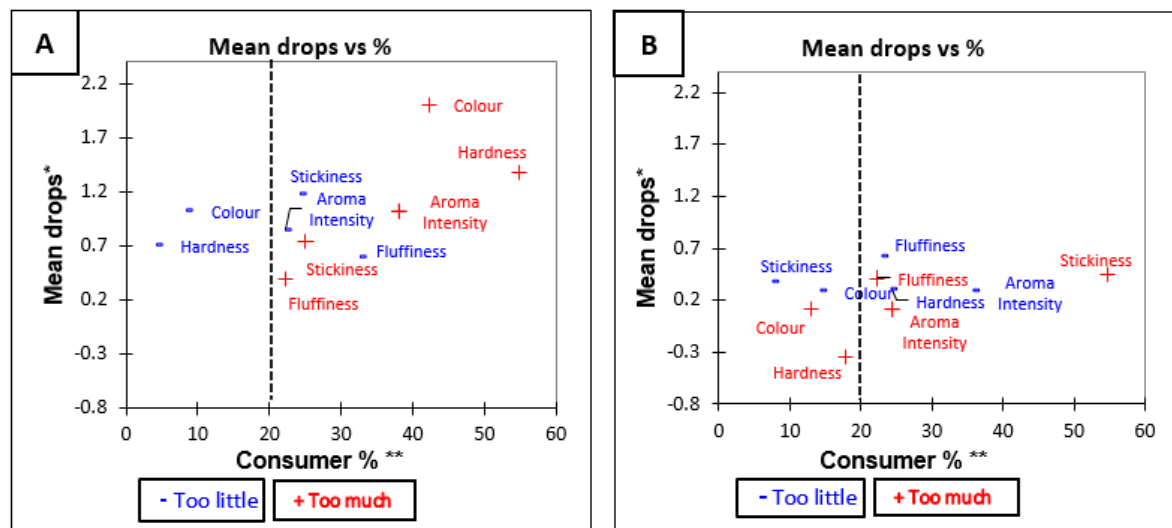
Figure 4. Mean drop plots for Medium Grain rice variety before tasting ( A ) Medium Grain Brown and ( B ) Medium Grain White. * Mean drop is the decrease in liking compared to the mean liking of those who rated the attribute as JAR. ** Consumer % are the consumers which judged an attribute as not ideal (Just About Right). The attributes with large percentages of consumers and penalties are in top right quadrant of the plot, which illustrates the critical points of the product